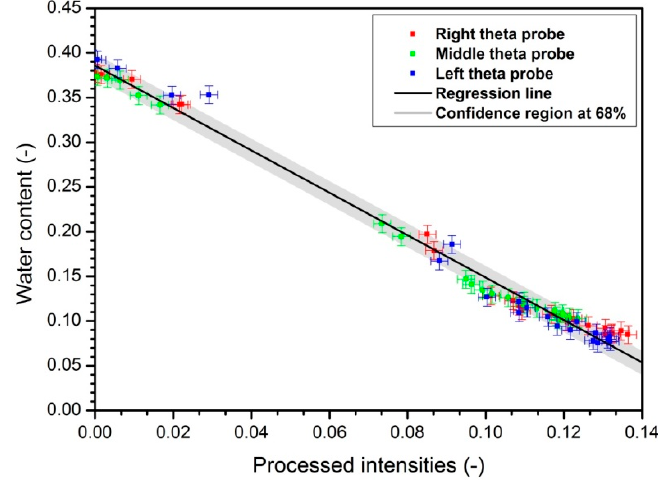
Table 2. Calibration parameters and statistics of linear regression.